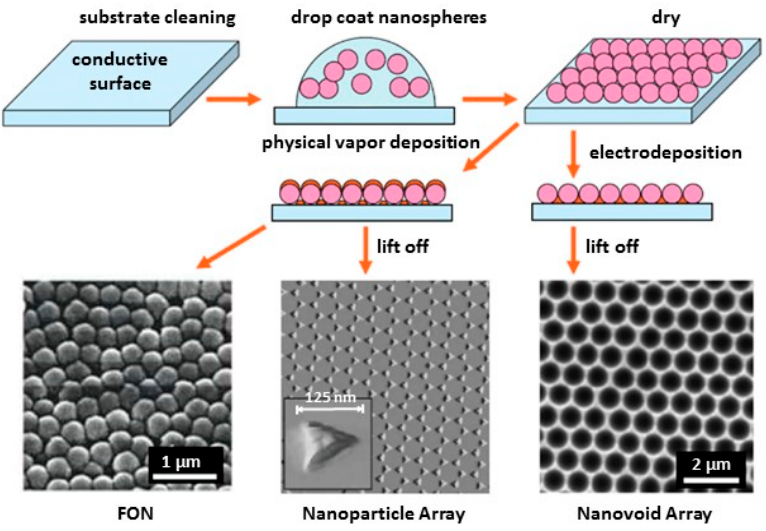
Figure 8. Schematic representation of the nanosphere lithography process for fabricating metal film over nanosphere (FON), periodic nanoparticle arrays, or nanovoid arrays. Reproduced with permission from Royal Society of Chemistry, 2008 [95].